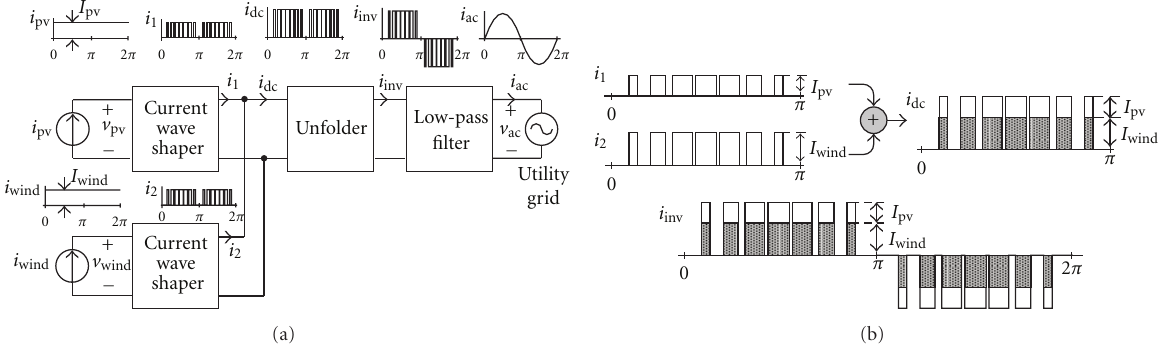
Figure 2: Conceptual expression of the proposed current sharing technique—(a) simplified block diagram and (b) current waveforms for showing the part shared by each energy